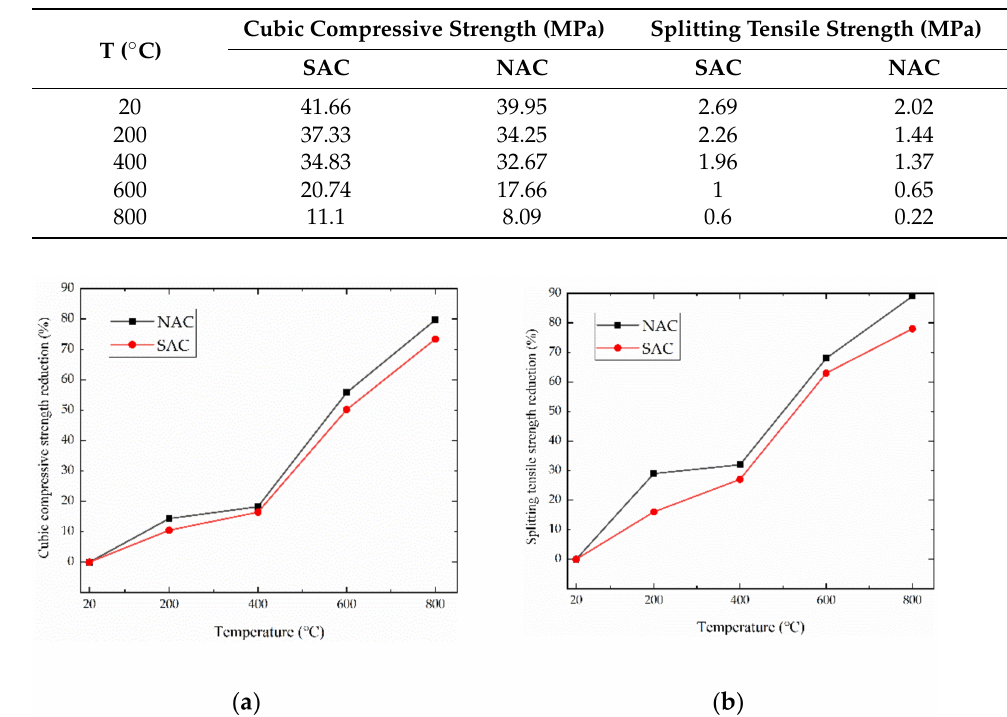
Figure 2. The strength reduction of NAC and SAC after fire: ( a ) the cubic compressive strength reduction of NAC and SAC after fire; ( b ) the splitting tensile strength reduction of NAC and SAC after